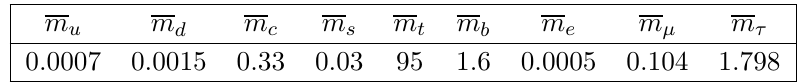
Table 1 . The experimental values of quark and charged lepton masses (in GeV) at (cid:22) = 10 7 GeV, obtained from NNLO QCD RG evolution, and used for comparison with the numerical scan. Despite the large allowed experimental range for m u and m d we show only the central values, which coincide with the choice made in ref. [27] at (cid:22) = 2